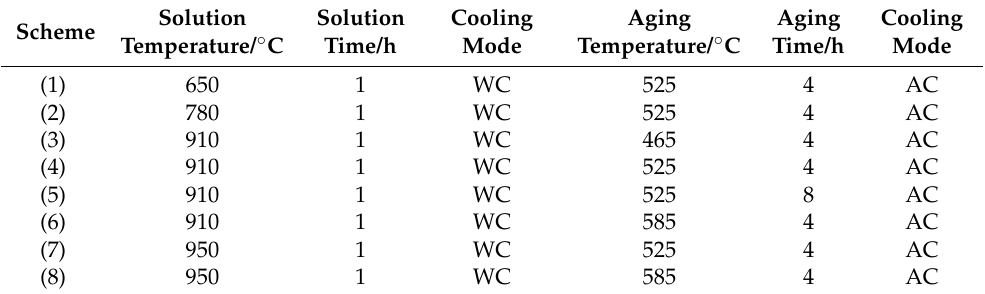
Table 3. Solution-aging treatment scheme for the tube after the TSR process.